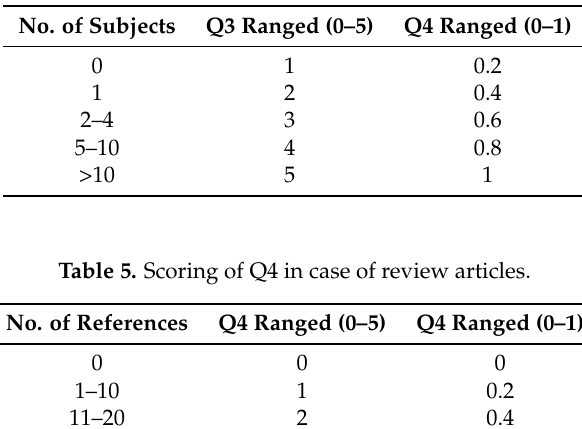
Table 4. Scoring of Q3: Number of patients/subjects participated in the study.